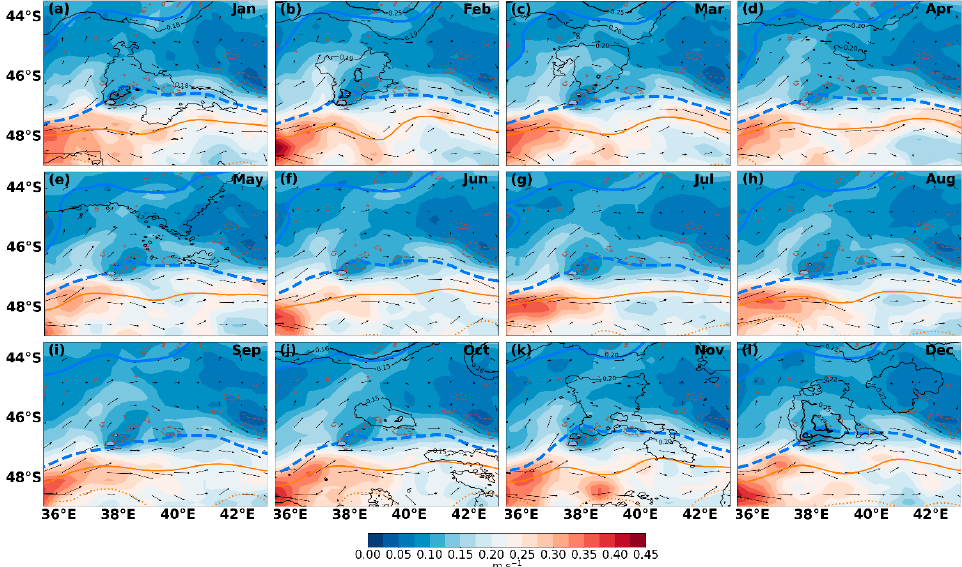
Figure 11. ( a – l ) Monthly (January to December) climatology (1993–2020) of geostrophic current speed (m s − 1 ). The vectors indicate the direction of current flow, while the black contours indicate the lowest and highest chla (mg m − 3 ) concentrations that formed unique closed contours in our re- gion of interest for each month (0.18 and 0.25 in January; 0.19 and 0.25 in February; 0.20 and 0.25 in March; 0.20 in April; 0.17 in May; 0.15 and 0.16 in October; 0.20 and 0.25 in November; 0.22, 0.25, and 0.29 in December). The dashed brown contours indicate the 1000 m isobath. The solid and dashed thick blue lines show the climatological mean positions of the middle (M-SAF) and southern (S-SAF) branches of the sub-Antarctic Front, respectively. The solid and dotted orange lines illus- trate the climatological mean positions of the northern (N-APF) and middle (M-APF) branches of the Antarctic Polar Front, respectively.